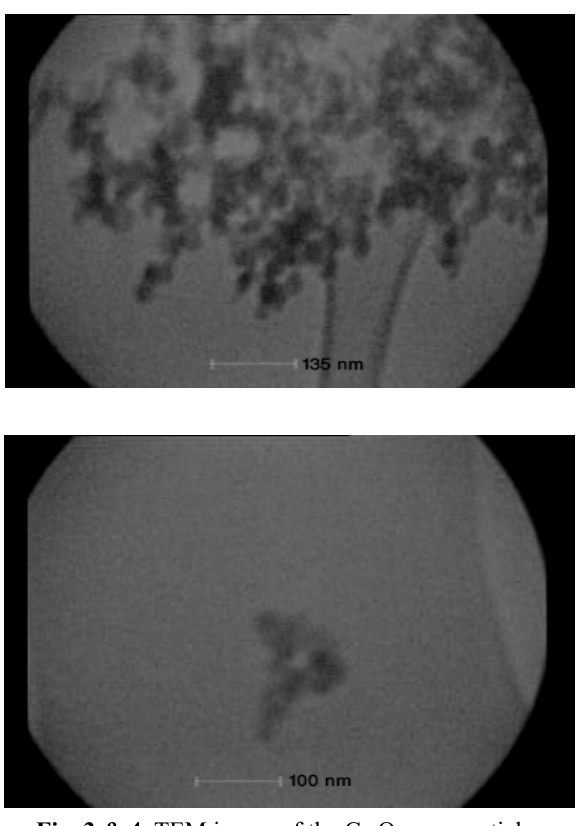
Fig. 3 & 4. TEM image of the Cr